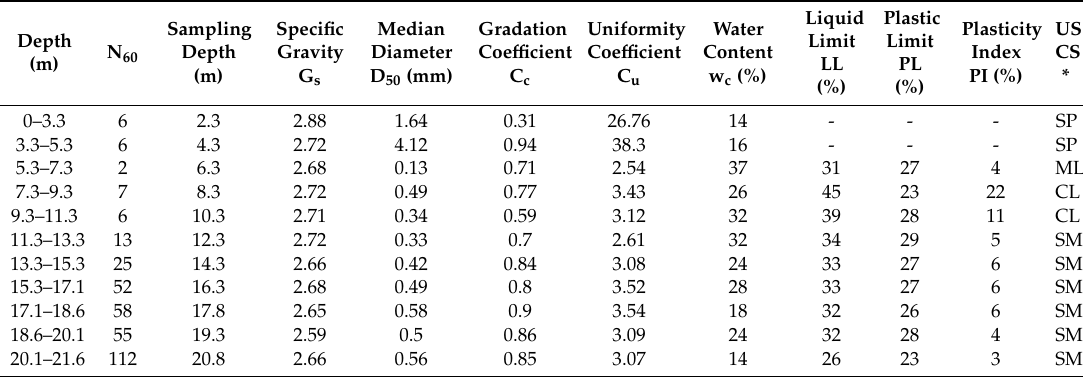
Table 1. Properties of soil sampled at site